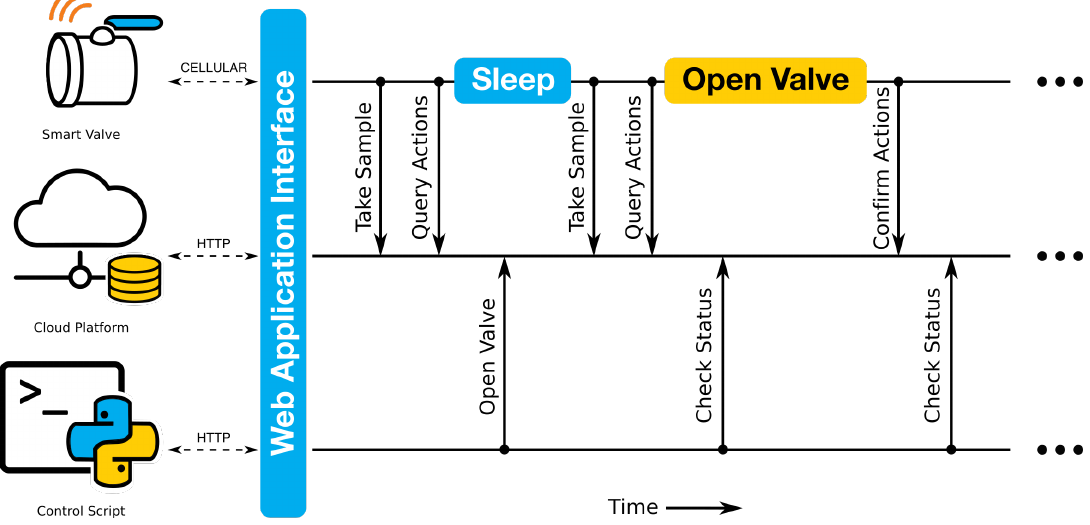
Figure 2. Control system architecture. Field-deployed nodes use a polling system to download and execute commands issued from a remote server. Control actions can be specified manually, or through automated web applications and